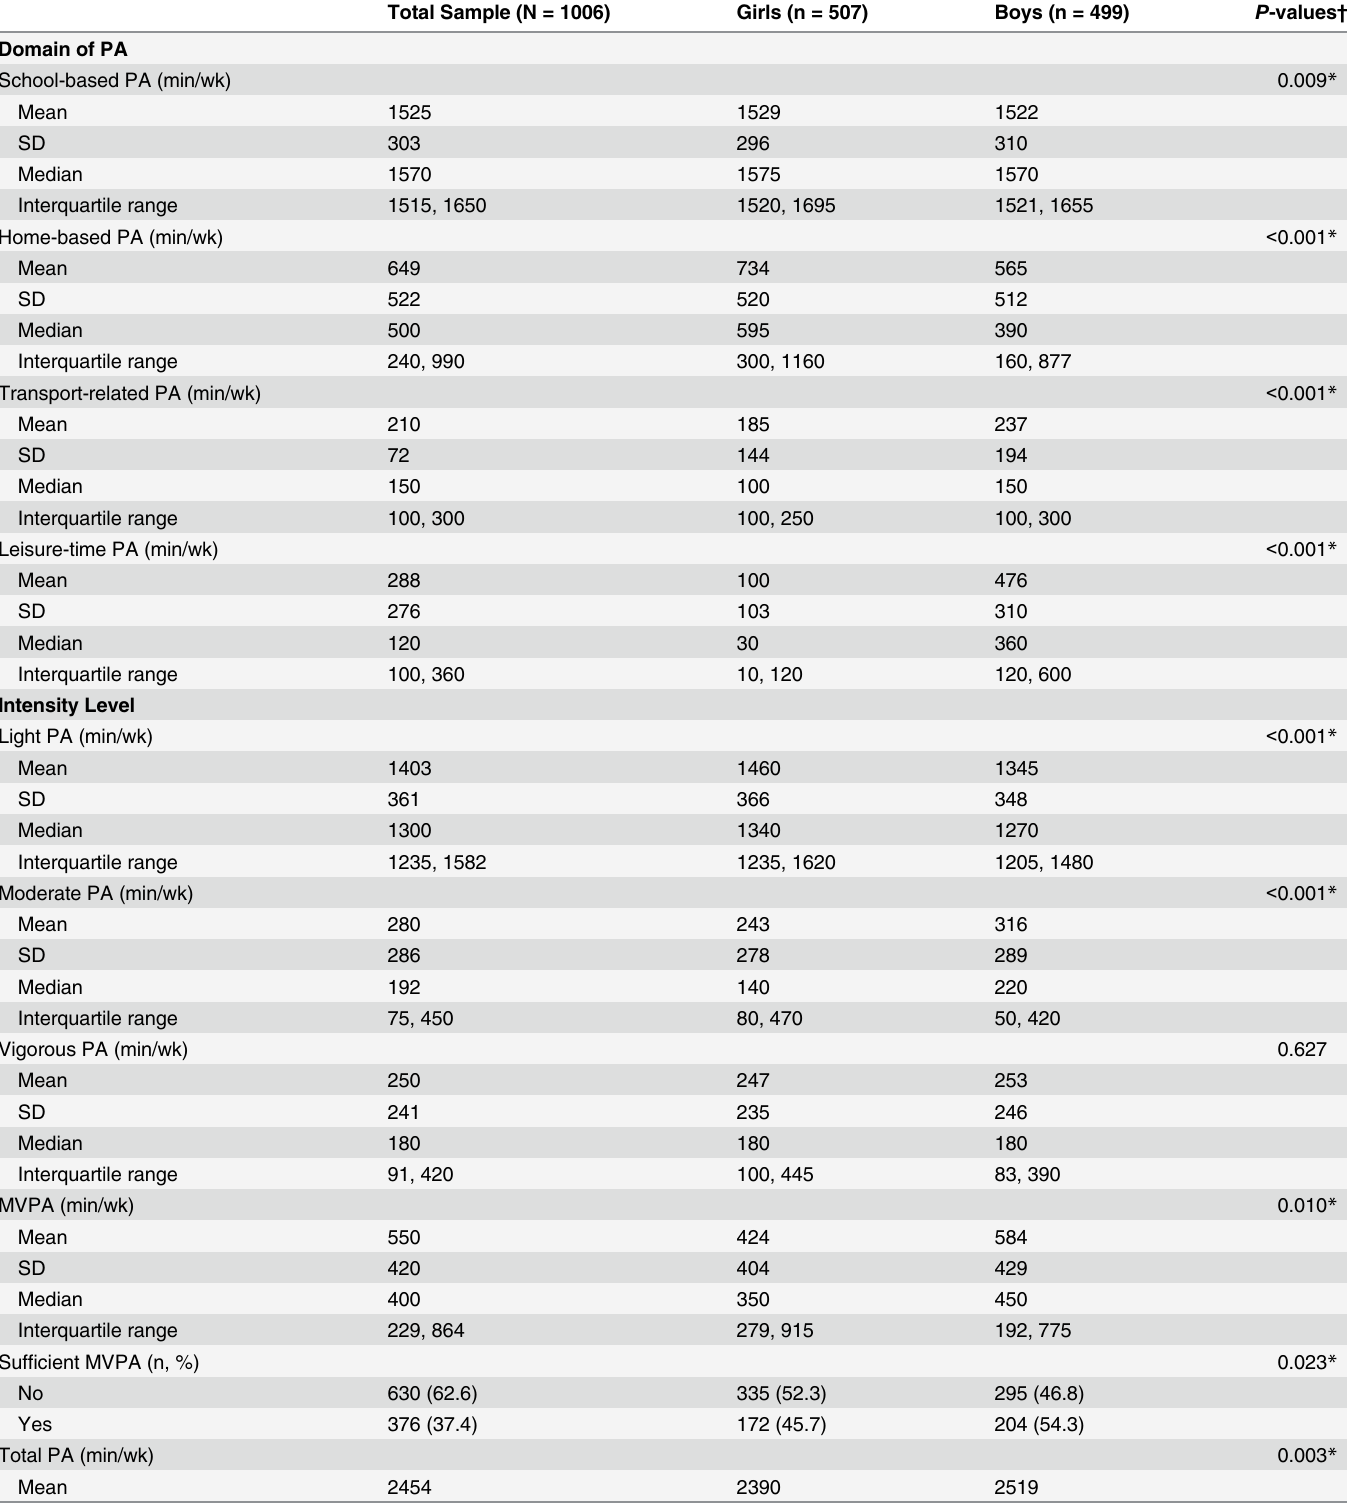
Table 2. Participants ’ physical activity per domain and intensity for total sample and by